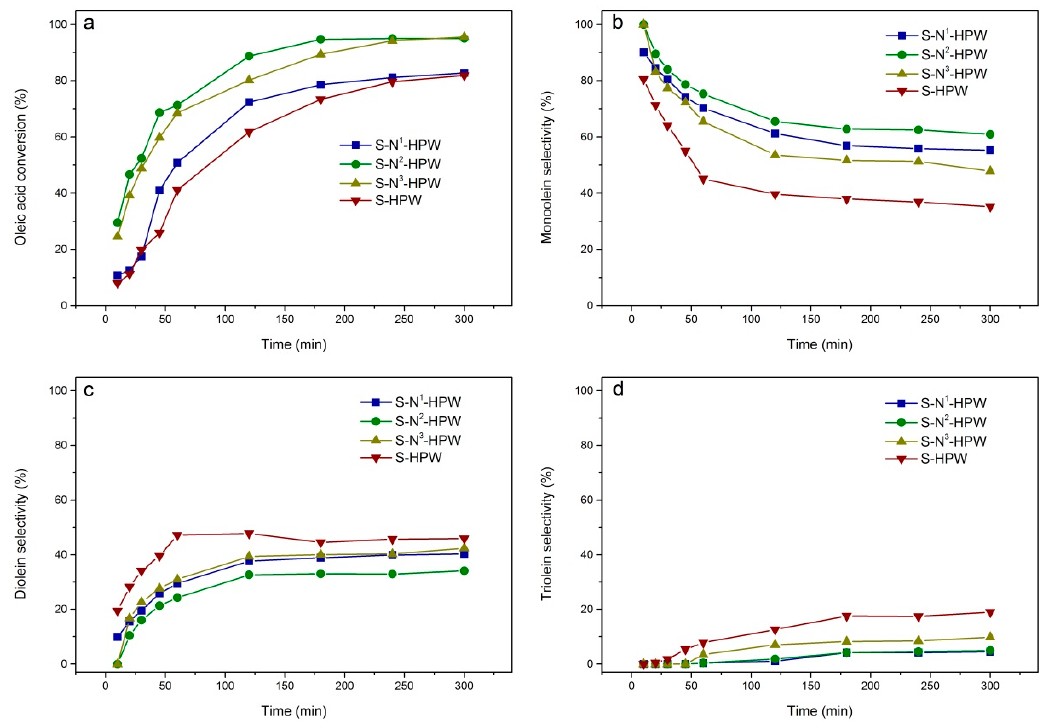
Figure 5. Catalytic activity of S-N x -HPW and S-HPW catalysts ( a ) and the corresponding product distributions ( b – d ) in the esterification of glycerol with oleic acid for 10–300 min at 160 °C using glycerol/oleic acid molar ratio of 4:1 and 2.5 wt % of catalyst loading.